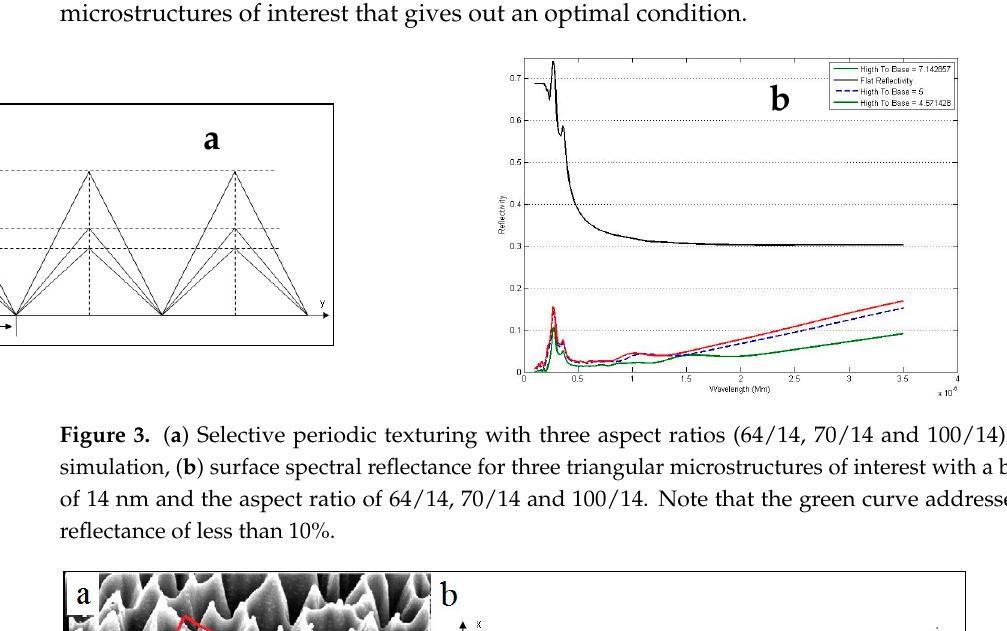
Figure 5. ( a ) Spectral reflection using simulation of the texturing with different coefficients of y 1 and y 2 equations and periodicities of 11, 21, 25 having 30 μ m. The height of the structure for the period of 30 μ m is set to be 15 μ m, ( b ) comparison of two microstructures with periods of 25 and 30 μ m. Note that the larger the number of ripples, the lower the skin's spectral reflectance. The surfaces related to triangular structures are not smooth, and ripples are observed on their surface. The effect of these ripples is further investigated by assuming the surface of triangular structures to be uneven. According to Figure 6, for a sample with 20 ripples of 200 nm height, the surface is less reflective than the structure with a smooth surface. However, for a sample with a surface of seven ripples with 100 nm height, then the reflec- tion rate is almost equal to that of the original sample. Hence, the unevenness of the mor- phology formed by excimer laser irradiation affects the spectral reflection and the larger the number of ripples, the lower the surface spectral reflectance. According to the experimental diagram that shows the height distribution of textur- ing formed on the silicon surface [9], the triangular microstructures with height distribu- tion, as shown in Figure 7a, are also simulated to investigate the effect of this phenome- non. Figure 7a plots the general microstructure for the simulation. According to Figure 7b, the simulation results of the size distribution and height of conical structures due to excimer laser radiation elevate the microstructure’s surface reflection of variable size com- pared to an integrated texturing of the same size. In Figure 7b, two microstructures with a base of 2900 nm and heights of 2510 and 7260 nm are selected as integrated microstruc- tures, and two series of 11 triangles together are considered to study the effect of height distribution.